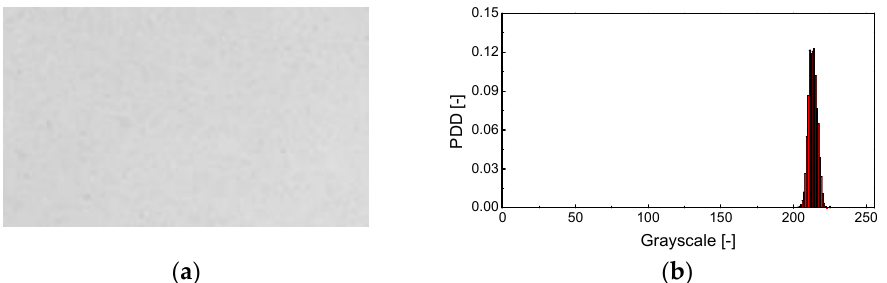
Figure 2. Original image of particle flow in liquid ‐ solid fluidized bed and its grayscale histogram. ( a ) Original image. ( b ) Grayscale histogram.